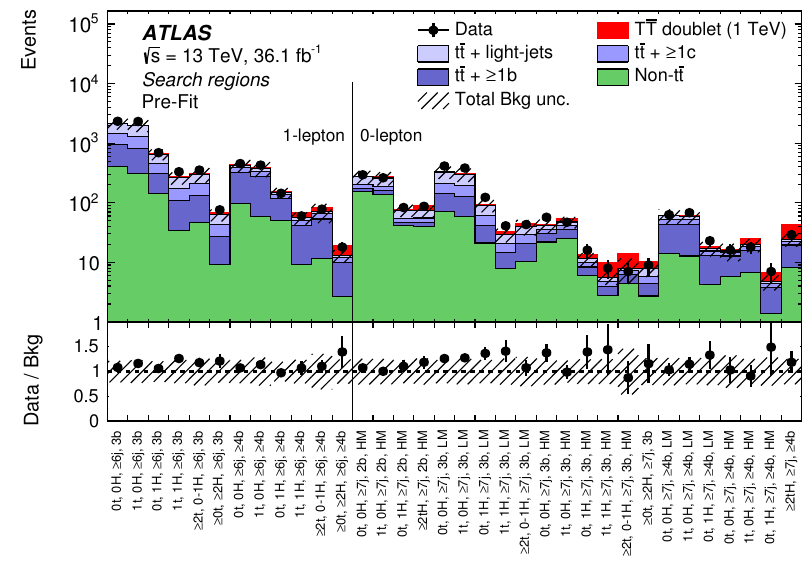
Figure 6. Comparison between the data and the background prediction for the yields in the search regions considered in the 1-lepton and 0-lepton channels, before the (cid:12)t to data (\Pre-(cid:12)t"). The small contributions from t (cid:22) tV , t (cid:22) tH , single-top, W=Z +jets, diboson, and multijet backgrounds are combined into a single background source referred to as \Non- t (cid:22) t ". The expected T (cid:22) T signal (solid red) corresponding to m T = 1 TeV in the T doublet scenario is also shown, added on top of the background prediction. The bottom panel displays the ratio of data to the SM background (\Bkg") prediction. The hashed area represents the total uncertainty of the background, excluding the nor- malisation uncertainty of the t (cid:22) t + 1 b background, which is determined via a likelihood (cid:12)t to (cid:21)